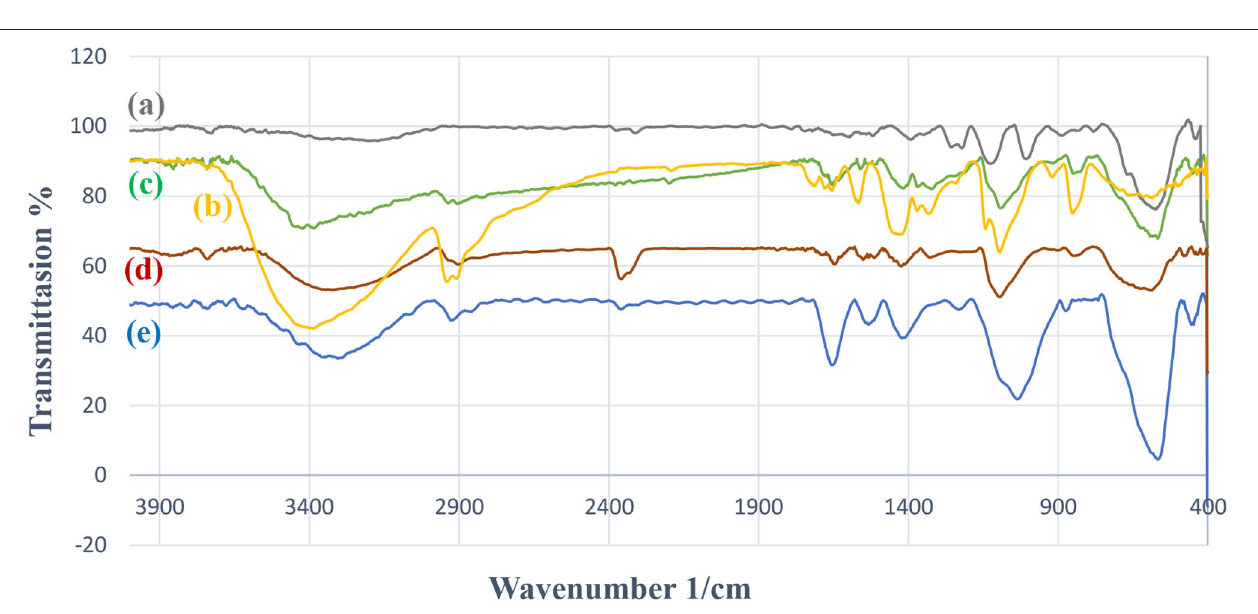
FIGURE 1 | FT-IR data of Fe 3 O 4 (a) , PVA (b) , Fe 3 O 4 @PVA (c) , Fe 3 O 4 @PVA-Cu (d) , and recovered Fe 3 O 4 @PVA-Cu (e)